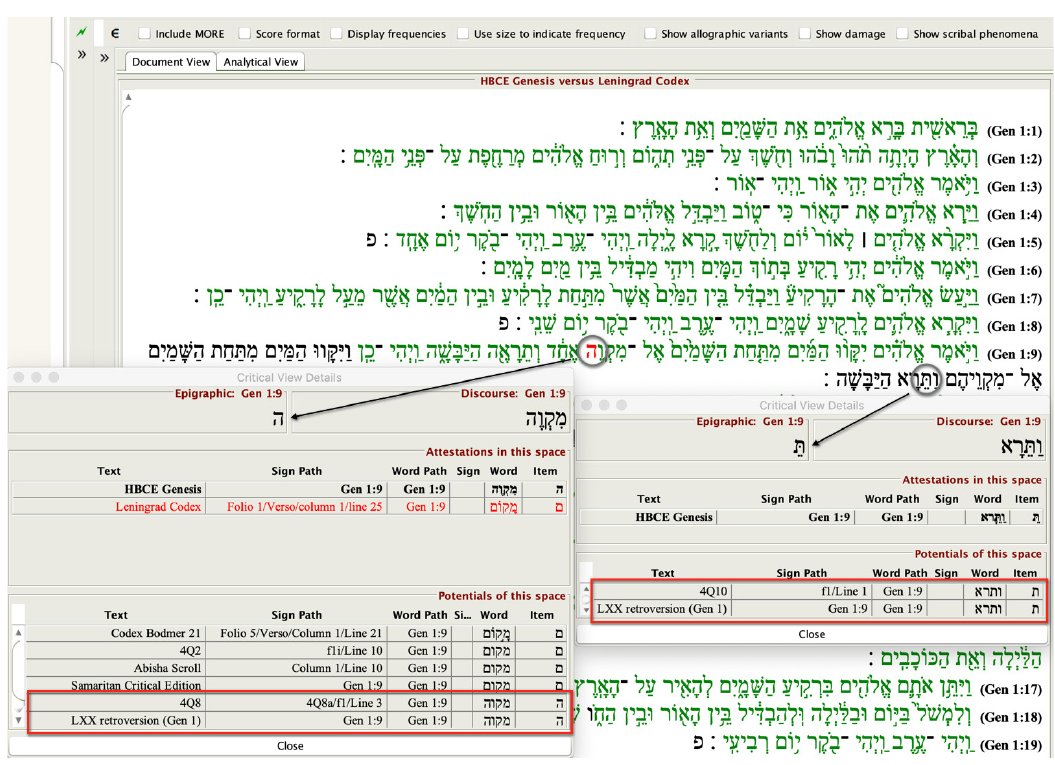
Figure 14: HBCE Genesis with Leningrad Codex overlaid; pop-up windows provide details Based on the information from the overlaid view, we now want to look at 4Q8 and 4Q10 along with the Septuagint manuscripts that attest this verse. When comparing across languages, CEDAR displays transcriptions side-by-side rather than overlaid. When we click on a word in any of the transcriptions, CEDAR highlights the equivalent word in all the rest. When we click on ה ֶו ְק ִמ in the HBCE edition, we can see the agreement in 4Q8 and the three Greek manuscripts. Nothing is highlighted in the Leningrad Codex because it has a different reading; nothing is highlighted in 4Q10 because it is fragmentary and does not attest this verse.